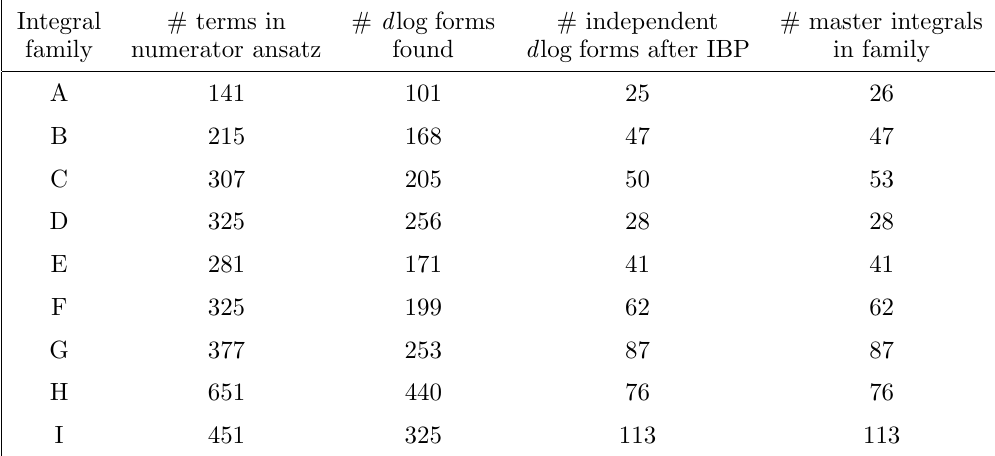
Table 2 . Application of the d log algorithm to the 3-loop integral